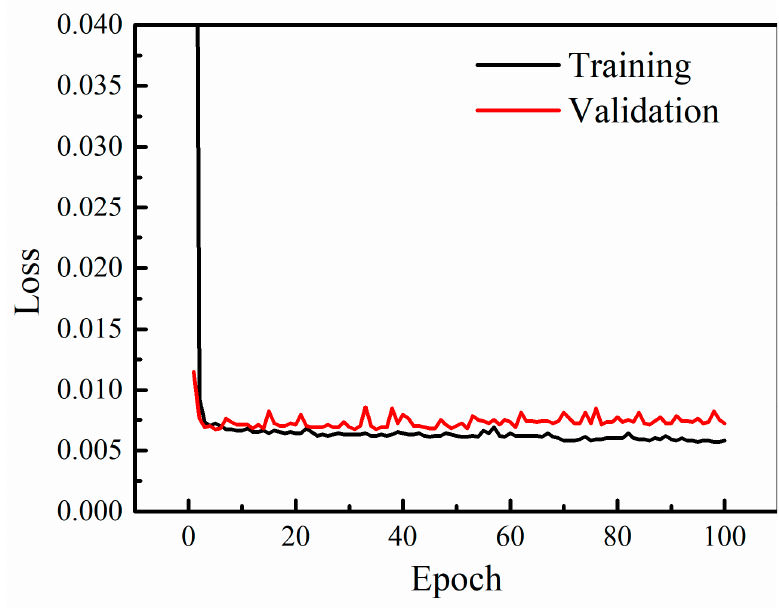
Figure 8. Loss curve of FNN model.